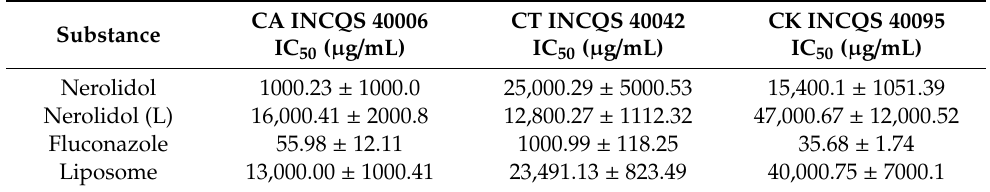
Figure 1. Growth curves of different Candida strains in the presence of fluconazole (FCZ), nerolidol and liposomal nerolidol (L). Liposomes without nerolidol were used as controls. ( A ) CA— Candida albicans ; ( B ) CT— Candida tropicalis ; ( C ) CK— Candida krusei; INCQS—National Institute for Quality Control in Health; concentration in μg/mL. Table 1. Inhibitory Concentration 50%-IC 50 values (μg/mL) of nerolidol against Candida strains.